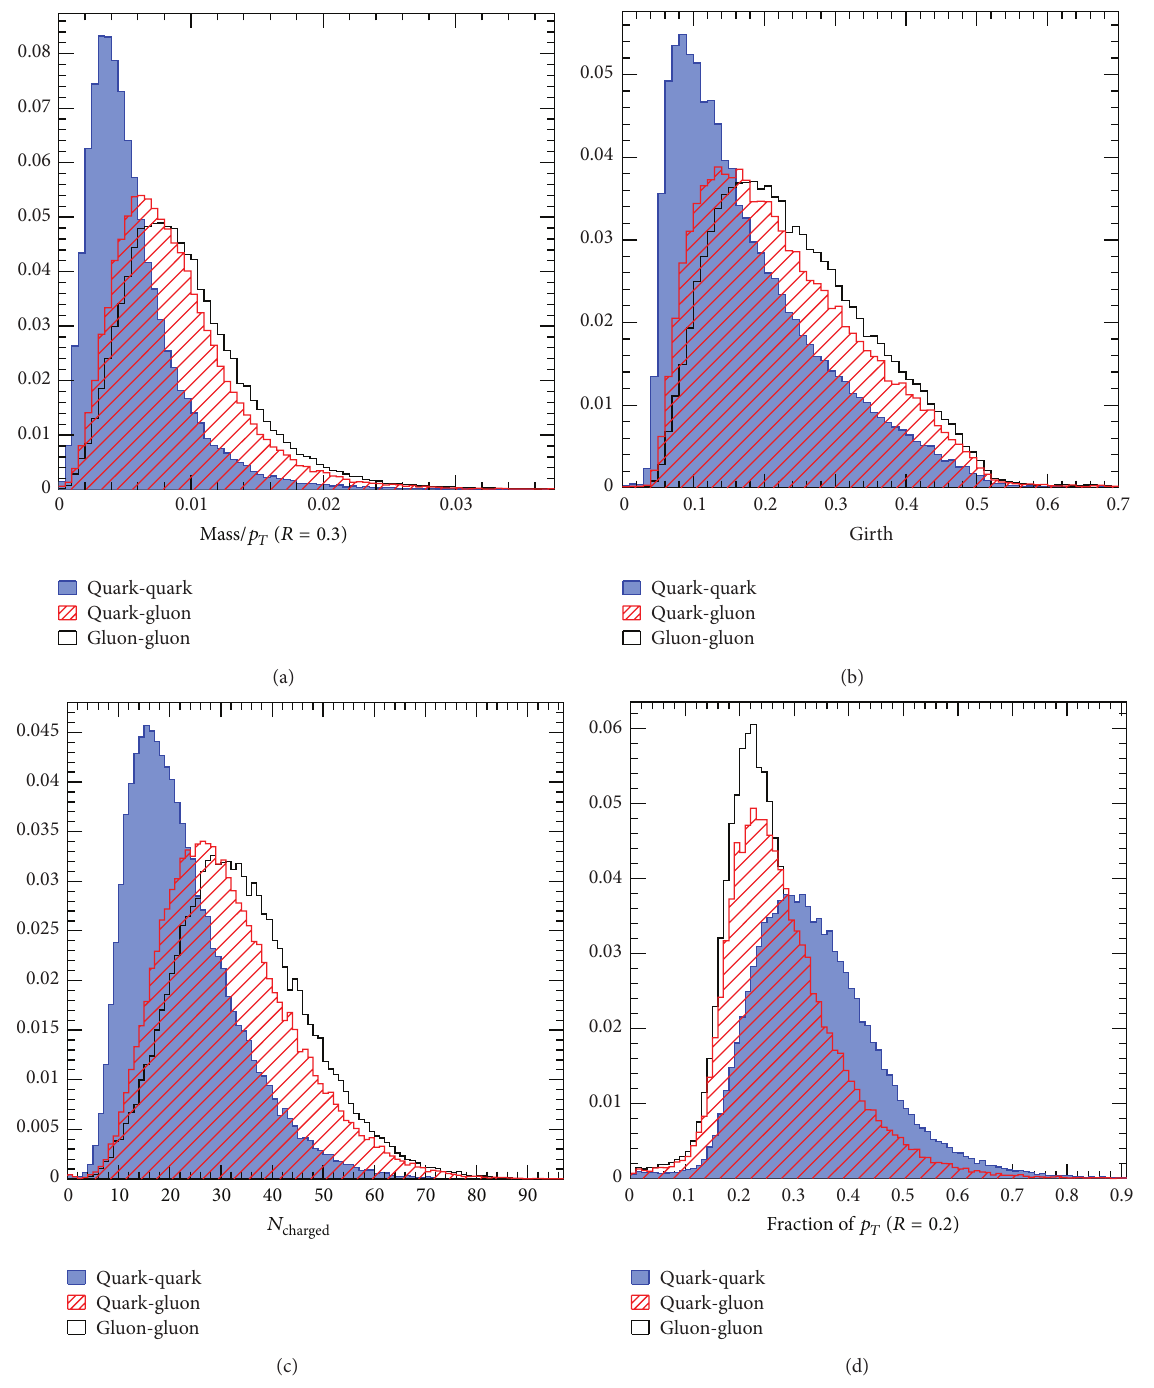
Figure 1: The distributions of selected variables from two leading jets: the ratio between jet mass and jet 𝑝 𝑇 with 𝑅 = 0.3 in (a), Girth in (b), charged particle multiplicities in (c), and fraction of jet 𝑝 𝑇 with 𝑅 = 0.2 in (d). Solid blue histograms present quark-quark final state, dashed red histograms show quark-gluon final state, and empty black lined histograms present gluon-gluon final state at the resonance mass of 3TeV.